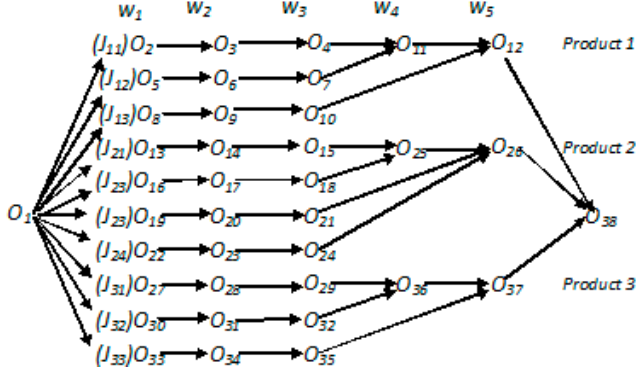
Figure 3. Operation-based representation of the assembly fl ow-shop problem.